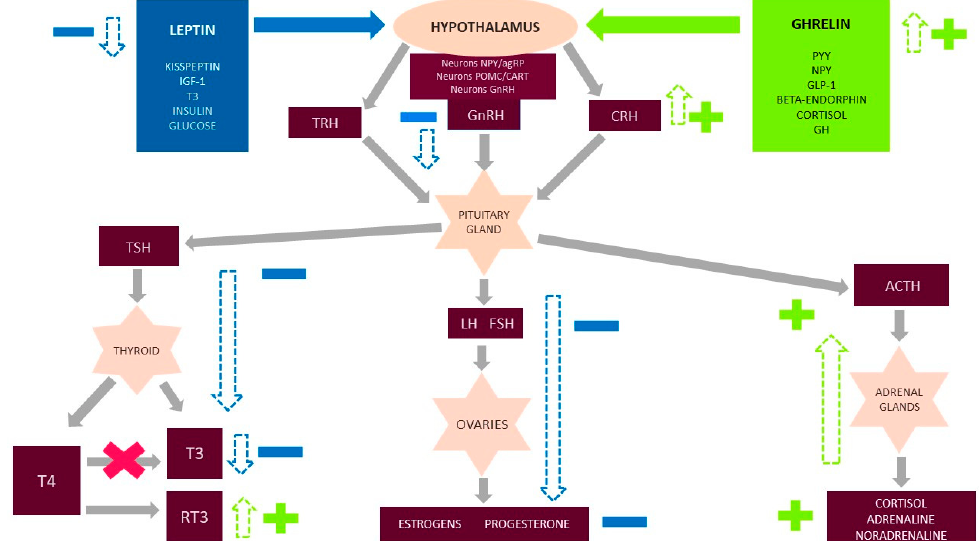
Figure 1. Functional hypothalamic amenorrhea (FHA) and influence on the endocrine system. Figure 1 shows the major hormone axis dysfunction caused by FHA, including the additional important neurohormonal factors that decrease (leptin, kisspeptin, IGF-1, FT3, insulin, and glucose) and increase (ghrelin and peptide YY (PYY), neuropeptide Y (NPY), growth hormone (GH), glucagon-like peptide 1 (GLP-1), beta-endorphins, and cortisol) in FHA. The hypothalamus secretes gonadotropin releasing hormone (GnRH), corticotropin-releasing hormone (CRH), and thyrotropin-releasing hormone (TRH), which then affect the pituitary gland and stimulate it to secrete tropic hormones: lutropin (LH), follicotropins (FSH), adrenocorticotropic hormone (ACTH), and thyroid-stimulating hormone (TSH). These hormones then affect the target organs. In turn, the ovaries, adrenal glands, and thyroid glands secrete hormones specific to them. Under physiological conditions, all hormonal axes are regulated by positive and negative feedback. A decreased concentration of hormones occurs in each of the secretory stages for the hypothalamus–pituitary–ovary (HPO) and hypothalamus–pituitary–thyroid (HPT) axes. Moreover, in the case of the thyroid gland, the conversion of T4 to the metabolically active form of T3 is disturbed. Instead, the inactive form reverse-T3 is produced in excess and blocks the receptors for